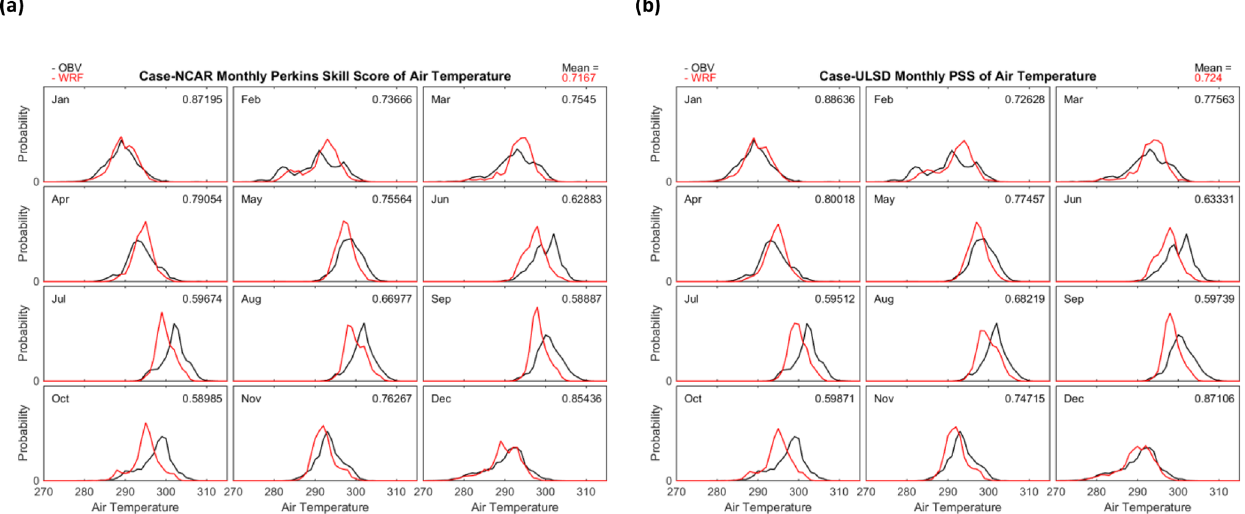
Figure 7. PSS monthly variation of 2m air temperature of Case-NCAR (a) and Case-ULSD (b) . Data source: Li et al. (2019a, b).